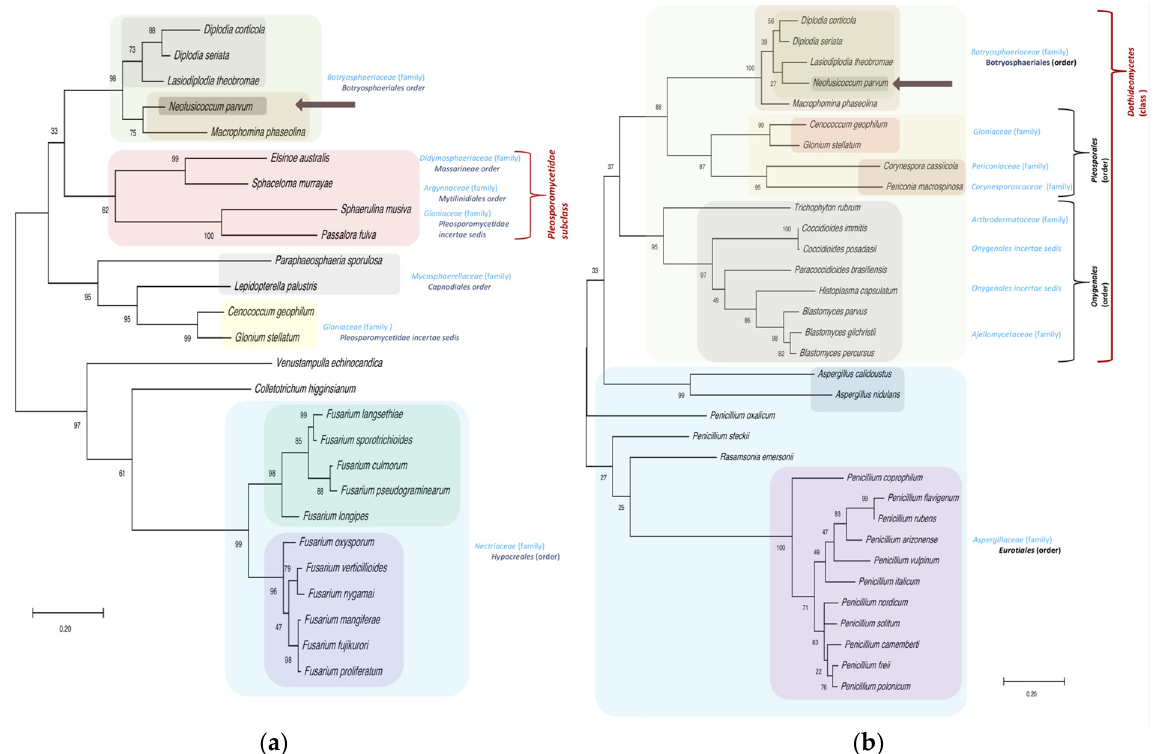
Figure 7. Phylogenetic analyses of NpCysRP4 and NpCysRP5 with orthologs from other fungal species. The phylogenetic trees were constructed using protein sequences with the maximum likelihood method and JTT matrix ‐ based model. NpCysRP4 and NpCysRP5 trees with the highest log likelihood values, ( − 4619.05) and ( − 6976.31), respectively, are shown. The percentage of trees in which the associated taxa clustered together is shown next to the branches. The trees are drawn to scale, with branch lengths measured in terms of the number of substitutions per site. ( a ) For NpCysRP4, the amino acid sequences are from D. corticola (XP_020129061.1), D. seriata (KKY13873.1), L. theobromae (KAB2571564.1), N. parvum